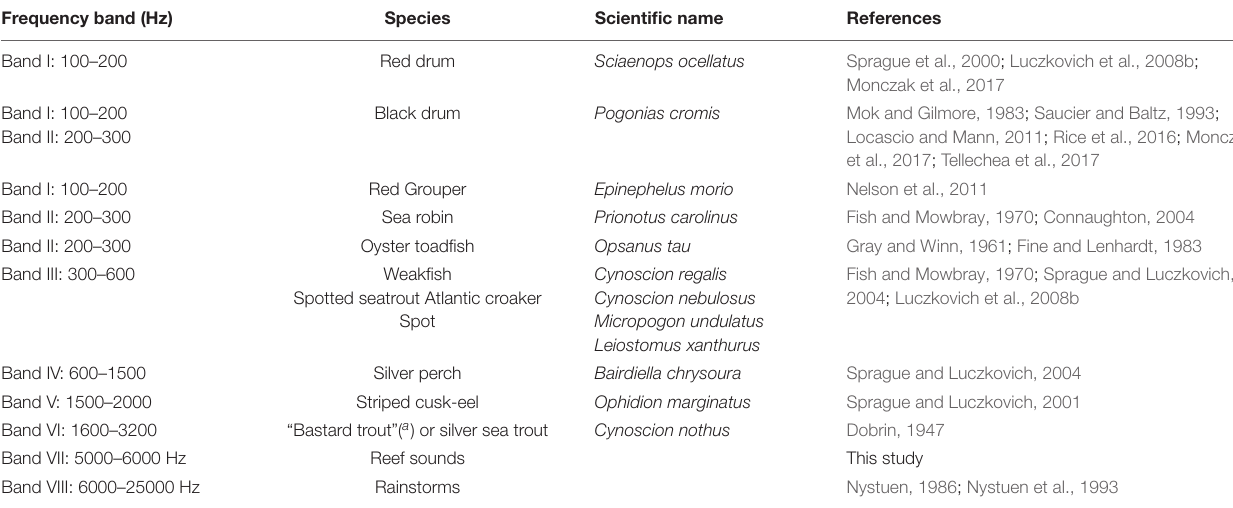
TABLE 2 | Frequency bands were used to associate fish species and power spectral band